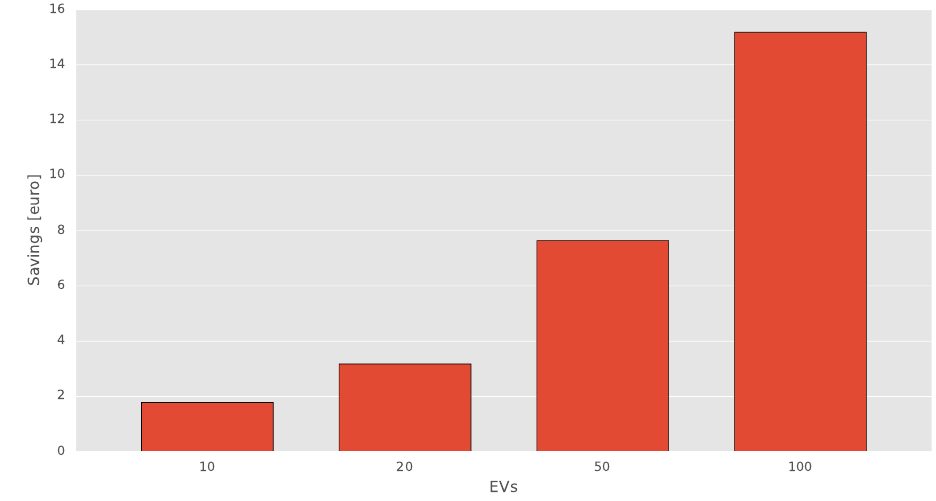
Figure 8. Average daily savings with the main scenario compared to the baseline scenario for a lead time of 0 intervals and a trading unit of